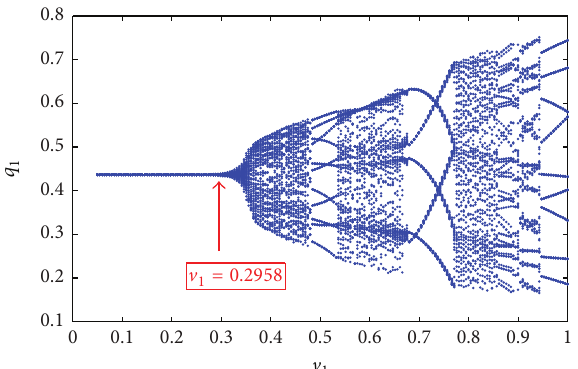
Figure 2: Bifurcation diagram with respect to parameter V 1 against variable 𝑞 1 with 500 iterations of map (8) for V 2 = 0.7, 𝑐 1 = 0.14, 𝑐 2 = 2 .